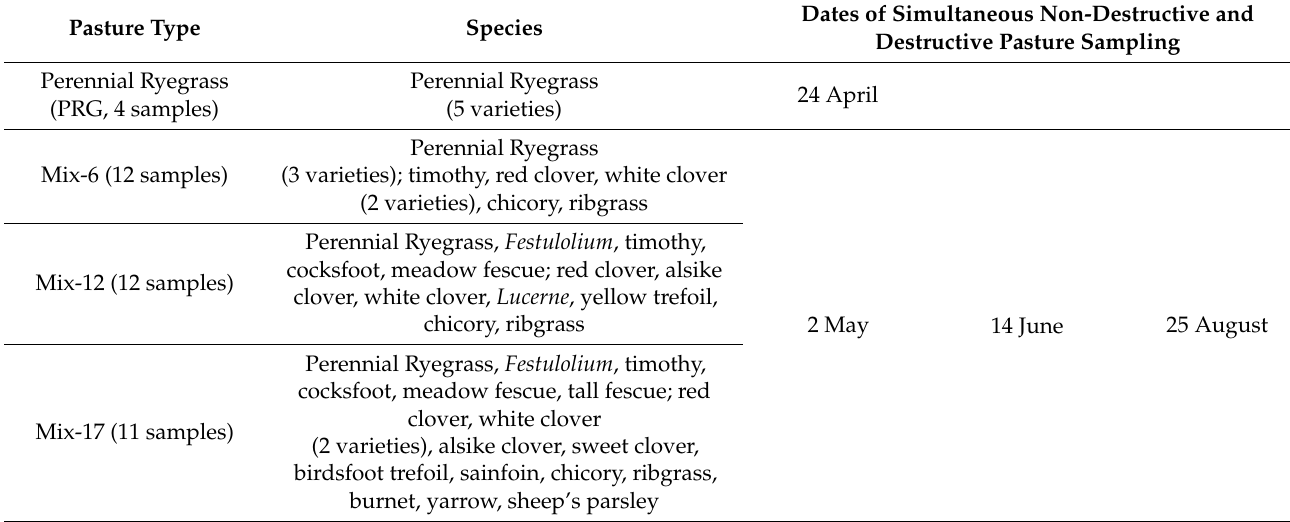
Table 1. A summary of the four pasture types (mixtures of perennial ryegrass, grasses, legumes and forbs), including species type and sampling dates in 2017. Each pasture species mix contains at least one variety of perennial ryegrass and then up to 16 other species, with the grasses, legumes and forbs in each mix listed in column 2. Grasses have been separated from legumes and forbs by semi-colon. Non-destructive sampling included measurements of Leaf Area Index (LAI) and spectral